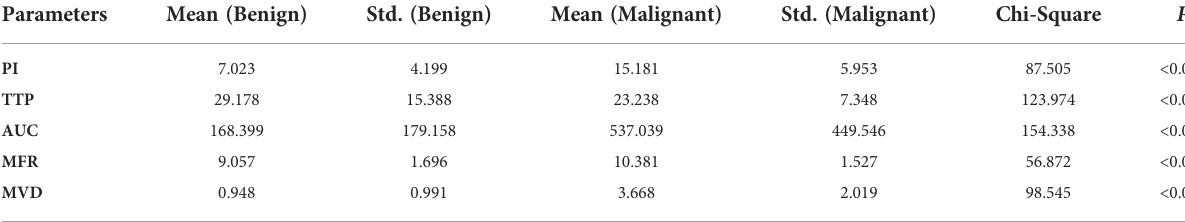
TABLE 2 Independent chi-square test of quantitative parameters in the diagnosis of benign and malignant breast masses. Parameters Mean (Benign)